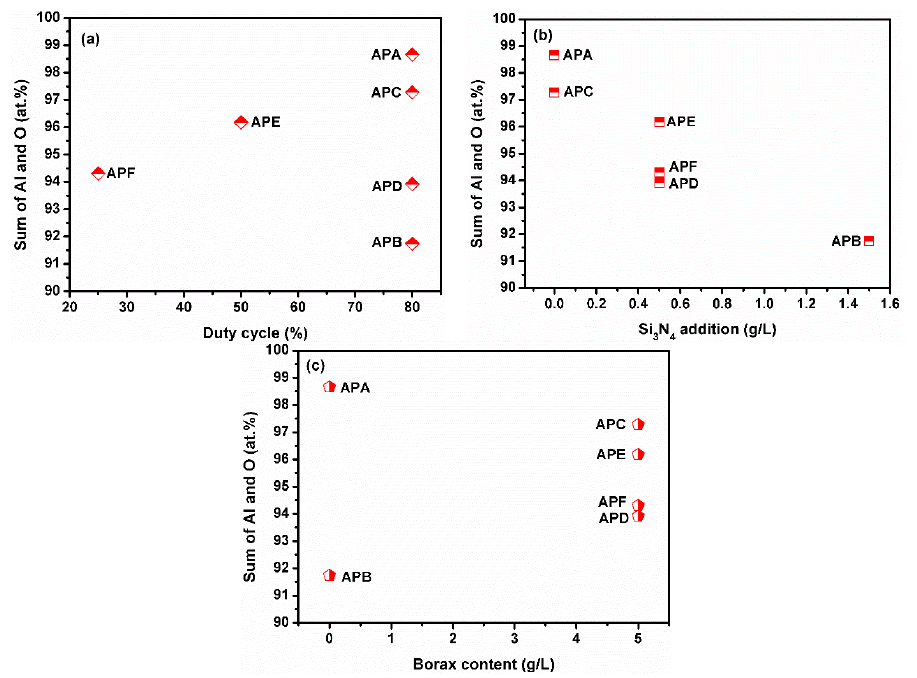
Figure 5. The dependence between sum of Al and O contents and ( a ) duty cycle, ( b ) Si 3 N 4 and ( c ) borax concentrations.